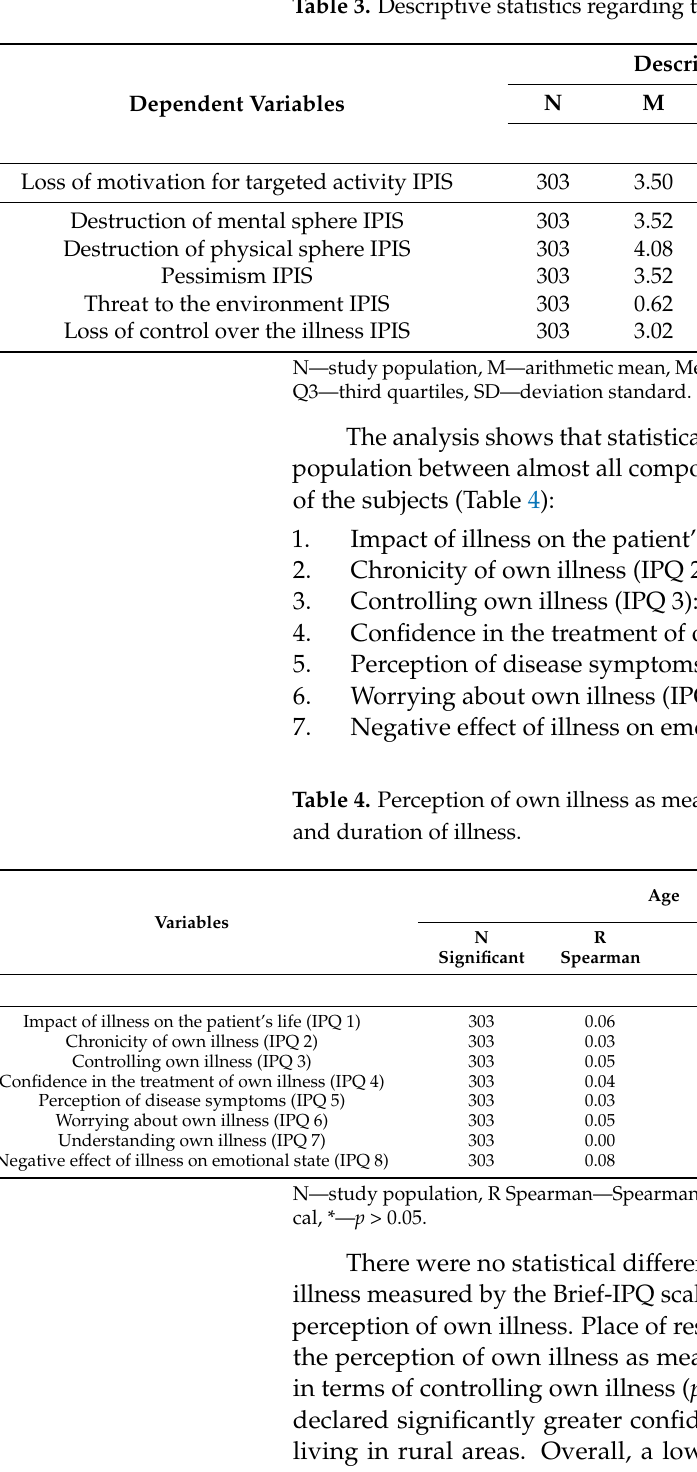
Table 3. Descriptive statistics regarding the perception of own illness as measured by the IPIS.